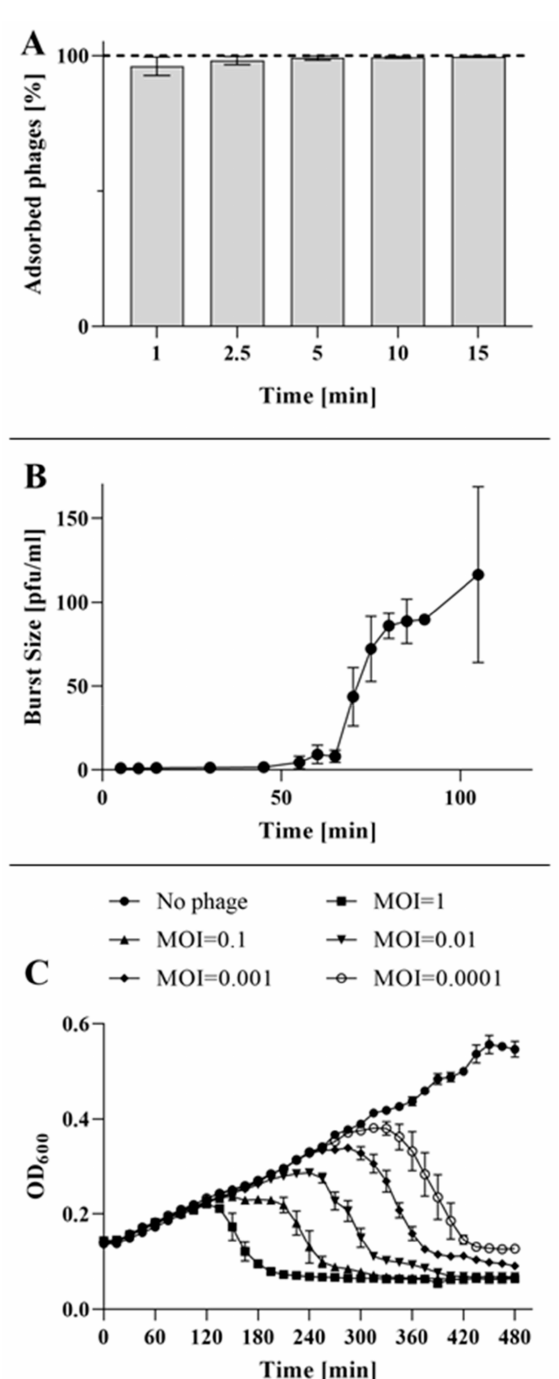
Figure 3. Phage BB8 development. ( A ) Adsorption of phage particles to the bacterial cells was assessed after 1, 2.5, 5, 10, and 15 min. ( B ) One-step growth curve shows that the eclipse period was a little under 60 min while latent period was around 75 min and resulted in the production of approx. 88 phage particles. ( C ) Collapse assay of the phage-infected bacterial culture indicated the high e ffi ciency of host cell lysis. Regardless of the MOI used, the bacterial culture was completely lysed by the phage. The presented results are average values from three experiments, with SD represented by error